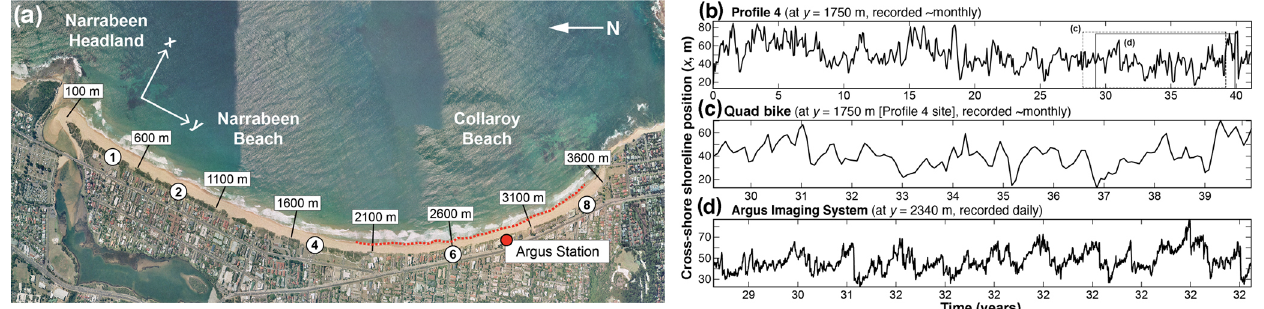
Figure 1. (a) Narrabeen–Collaroy beach, with locations of long time-series profiles (circled numbers) and Argus Imaging System coverage. Alongshore coordinates ( y ) are relative to the northern end, below Narrabeen Headland. (b) Long-term time series of cross-shore shoreline position (0.7m contour) at Profile 4, measured approximately monthly between 1976 and 2017. Time axis is in years since first measurement (27 April 1976). (c) Time series of cross-shore shoreline position at alongshore location y = 1750m (aligned with Profile 4), measured by quad bike approximately monthly between 2005 and 2017. (d) Time series of cross-shore shoreline position at alongshore location y = 2340m, measured daily by an Argus Imaging System between 2005 and 2016. Boxes (dotted, solid) in panel (b) frame the temporal coverages for the time series in panels (c) and (d)